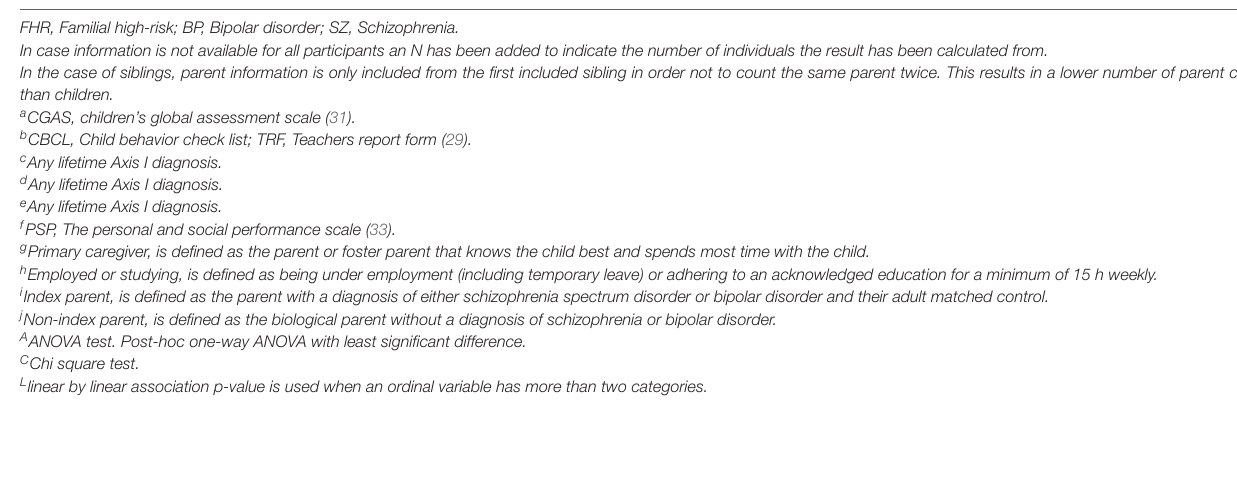
p -value FHR-BP vs. FHR-BP vs. controls controls